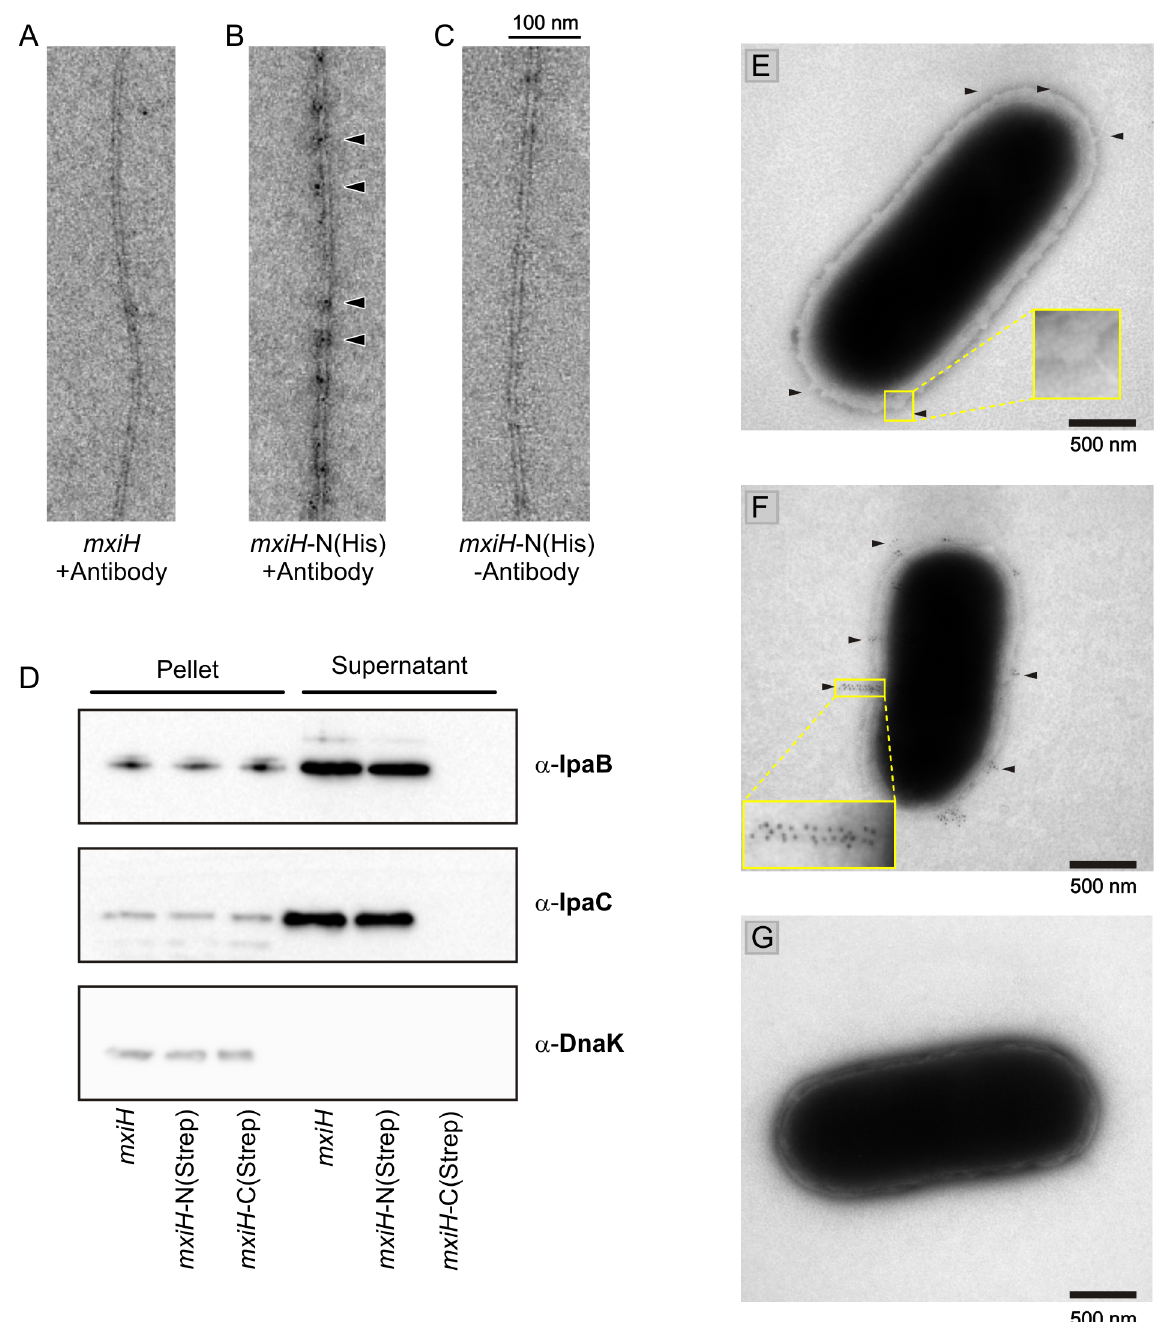
Figure 6. Localization of the MxiH subunit N-terminus invitro and invivo . A – C , Immunogold labeling of recombinant Shigella flexneri MxiH needles using a monoclonal Anti-His tag antibody. A , WT MxiH needles B , needles polymerized from N-terminal His tag fusion construct, mxiH -N(His), C , mxiH -N(His) needles labeled without primary Anti-His tag antibody. In B , some gold particles are indicated by arrows. Proteins expressed from a C- terminal His tag fusion construct did not polymerize. D , Effector protein secretion assay of Shigella strains used in Fig. E – G by addition of Congo Red (CR) followed by western blot analysis against IpaB, IpaC and DnaK. E – G , Non-polar Shigella mxiH-knockout cells ( D mxiH ) expressing E , wild-type mxiH , F , mxiH with N-terminal Strep-tag, mxiH -N(Strep) or G , MxiH with C-terminal Strep-tag, mxiH -C(Strep). In E and F , needles are indicated by arrows and two needles complexes are highlighted. doi:10.1371/journal.ppat.1003245.g006 more efficient by 1) only considering conformations that are propagating conformational changes to symmetry-related sub- consistent with the symmetry of the system and 2) performing a units. The PrgI template was used to define the initial rigid-body minimal number of energy and derivative evaluations by explicitly placement and backbone conformation of the MxiH subunits as simulating only a subset of the interacting monomers and well as their relative orientation with respect to each other,